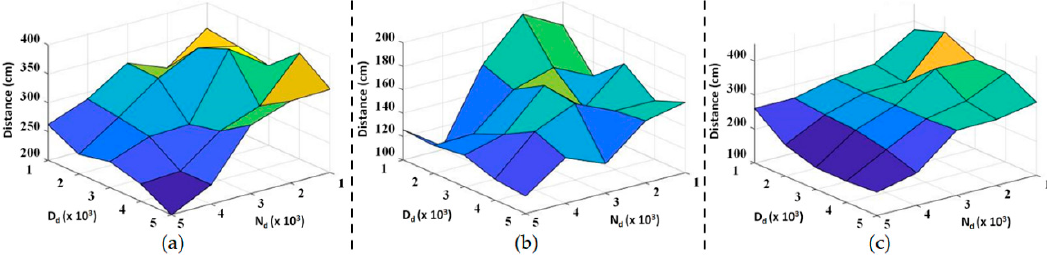
Figure 8. Three-dimensional plot of walking distance for a series of experiments as N d and D d vary from 1000 to 5000: ( a ) Subject 1; ( b ) Subject 2; and ( c ) Subject 3.